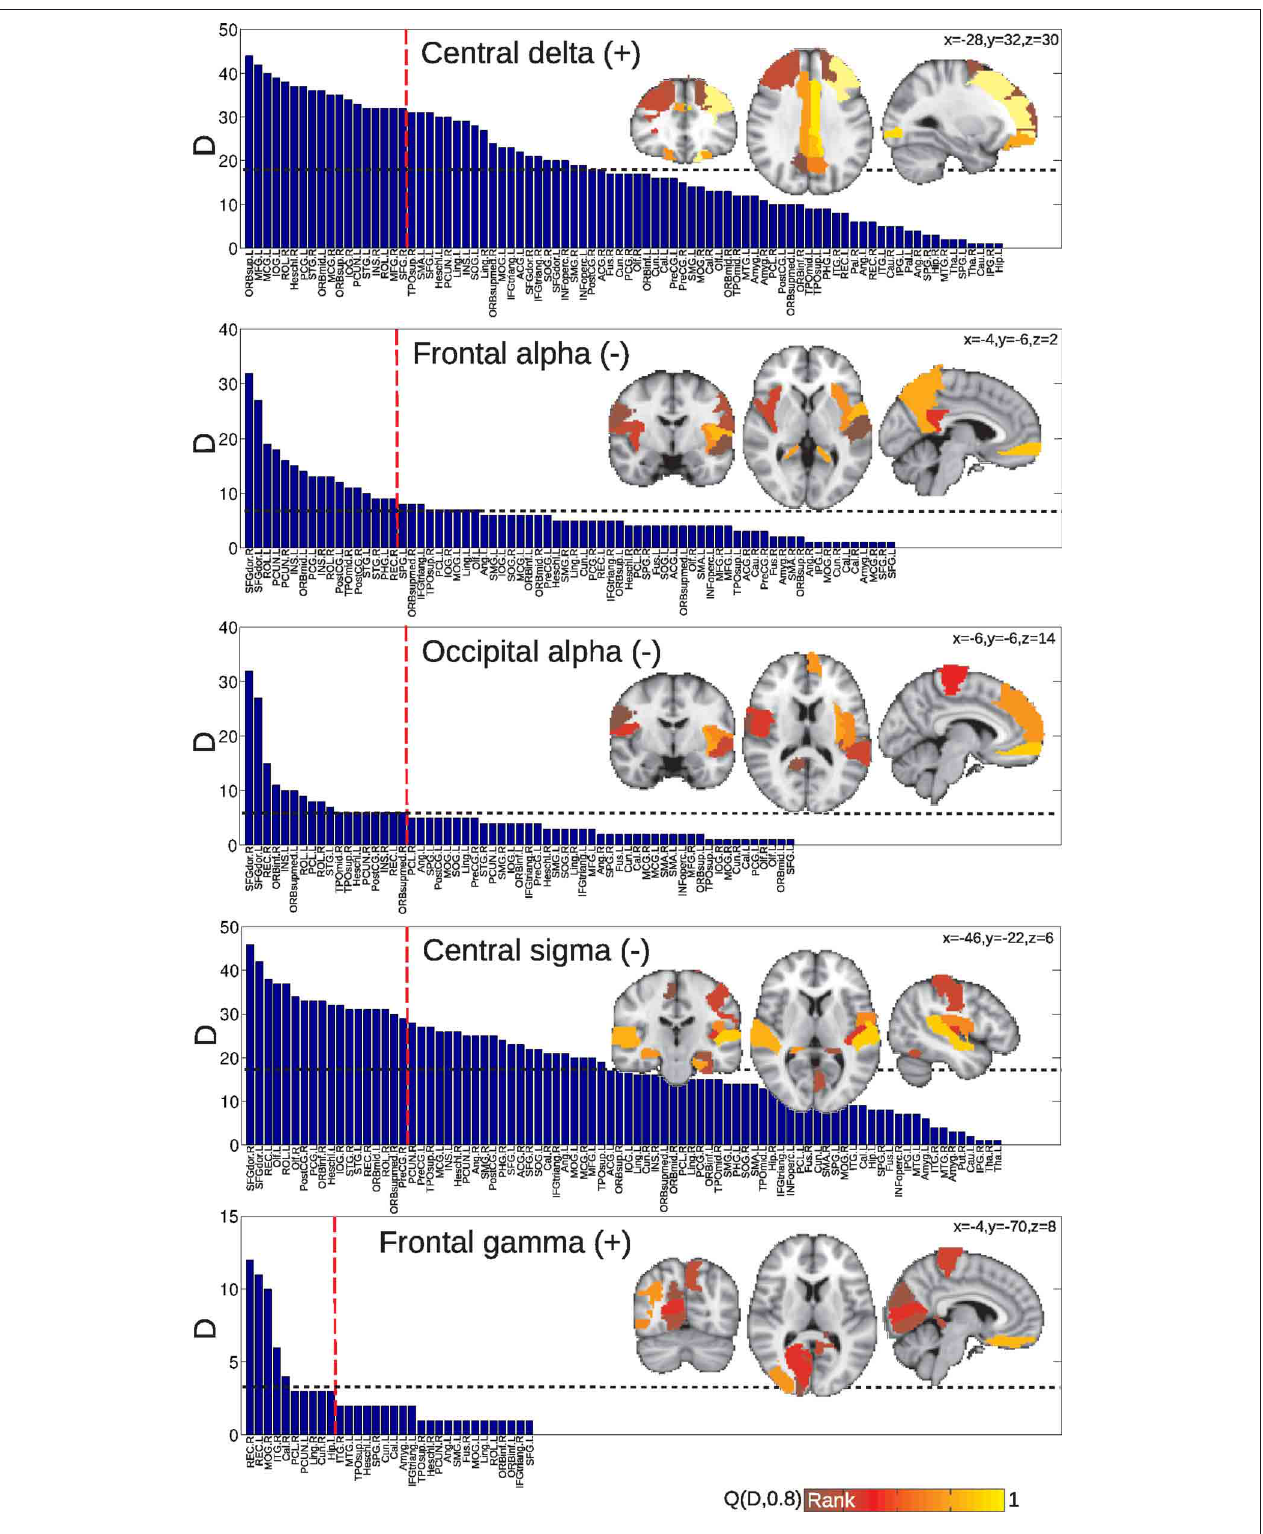
FIGURE 7 | Anatomical regions (or nodes) ranked according to the number of connections attached to them which correlate with EEG power fluctuations in different frequencies. In the inset, the regions corresponding to the top quintile of the distribution—denoted as